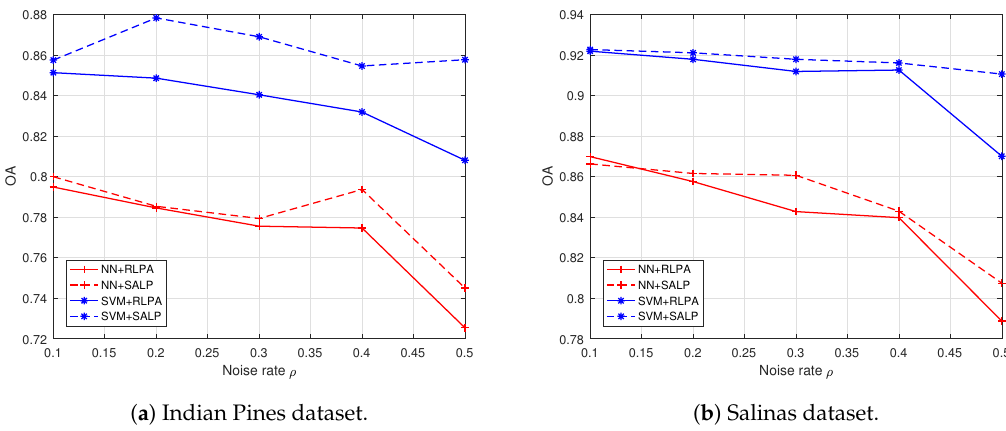
Figure 7. OA trend of RLPA and SALP over NN and SVM with the “both” setting. The proposed SALP is marked by imaginary line, and the RLPA is marked by solid line. The results of NN is labeled in red “+”, and that of SVM is labeled in blue ”*“.